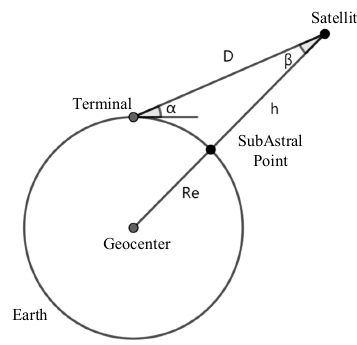
Figure 5. The space geometry of a communication link between a satellite and a terminal.